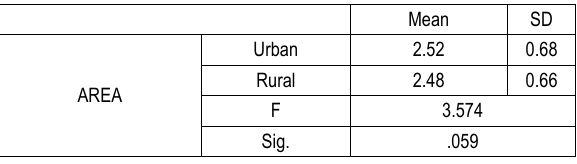
Table 3. Awareness status of mobile